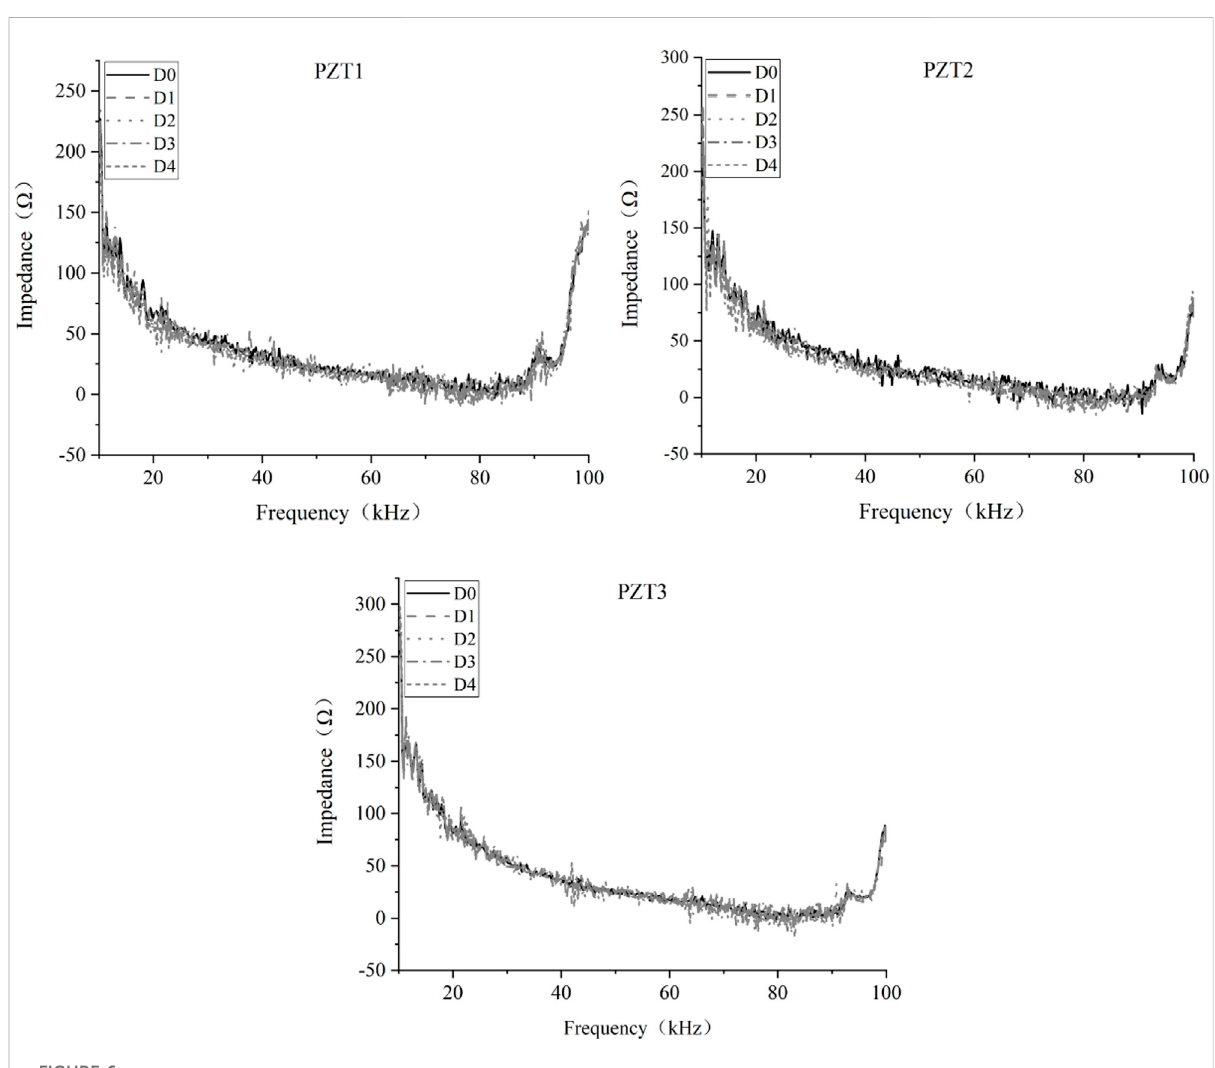
FIGURE 6 Impedance curve of the PZT sensors of BE0 with different damage